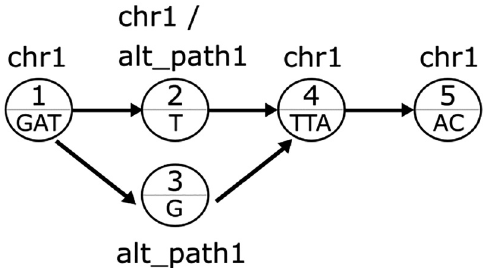
Figure 1: Example of a variation graph with a biallelic SNP. The two alternative bases are included in two distinct